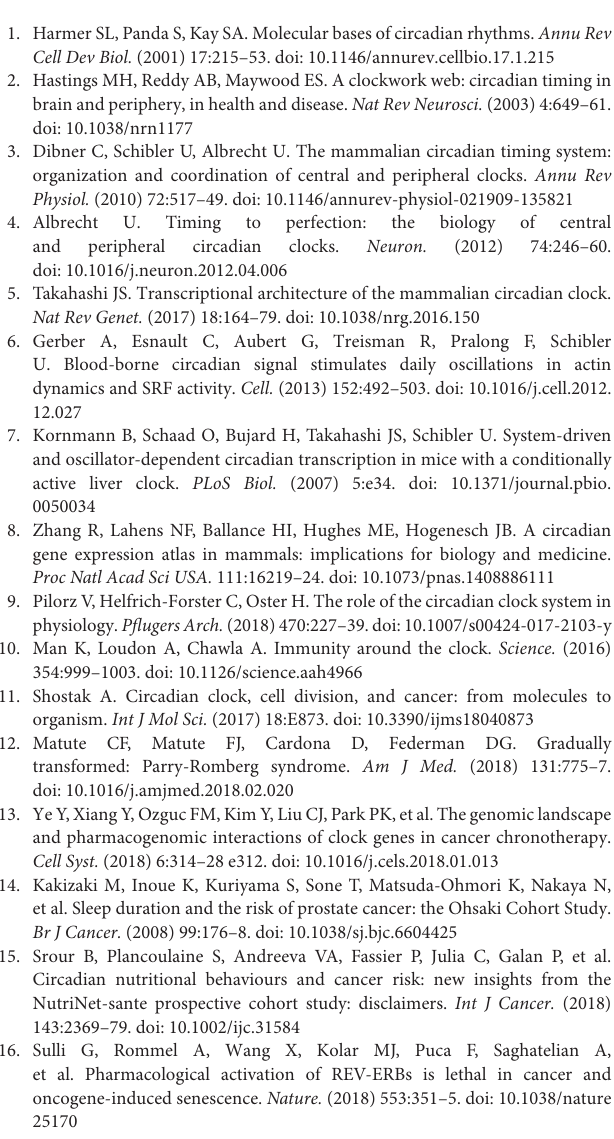
Figure S3 | Gene set enrichment analysis of signaling pathways among all core circadian clock genes. Selected enriched pathways of (A) RORC, (B) NR1D2, (C)